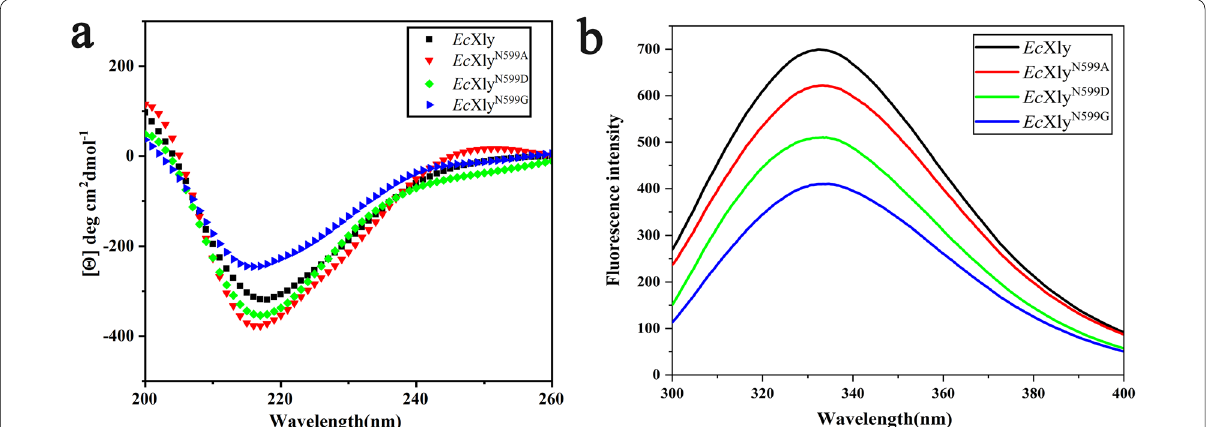
Fig. 7 The structural analysis of Ec Xly and its mutants ( Ec Xly N599A , Ec Xly N599D and Ec Xly N599G ). a Far-UV CD spectra. b The fluorescence spectra